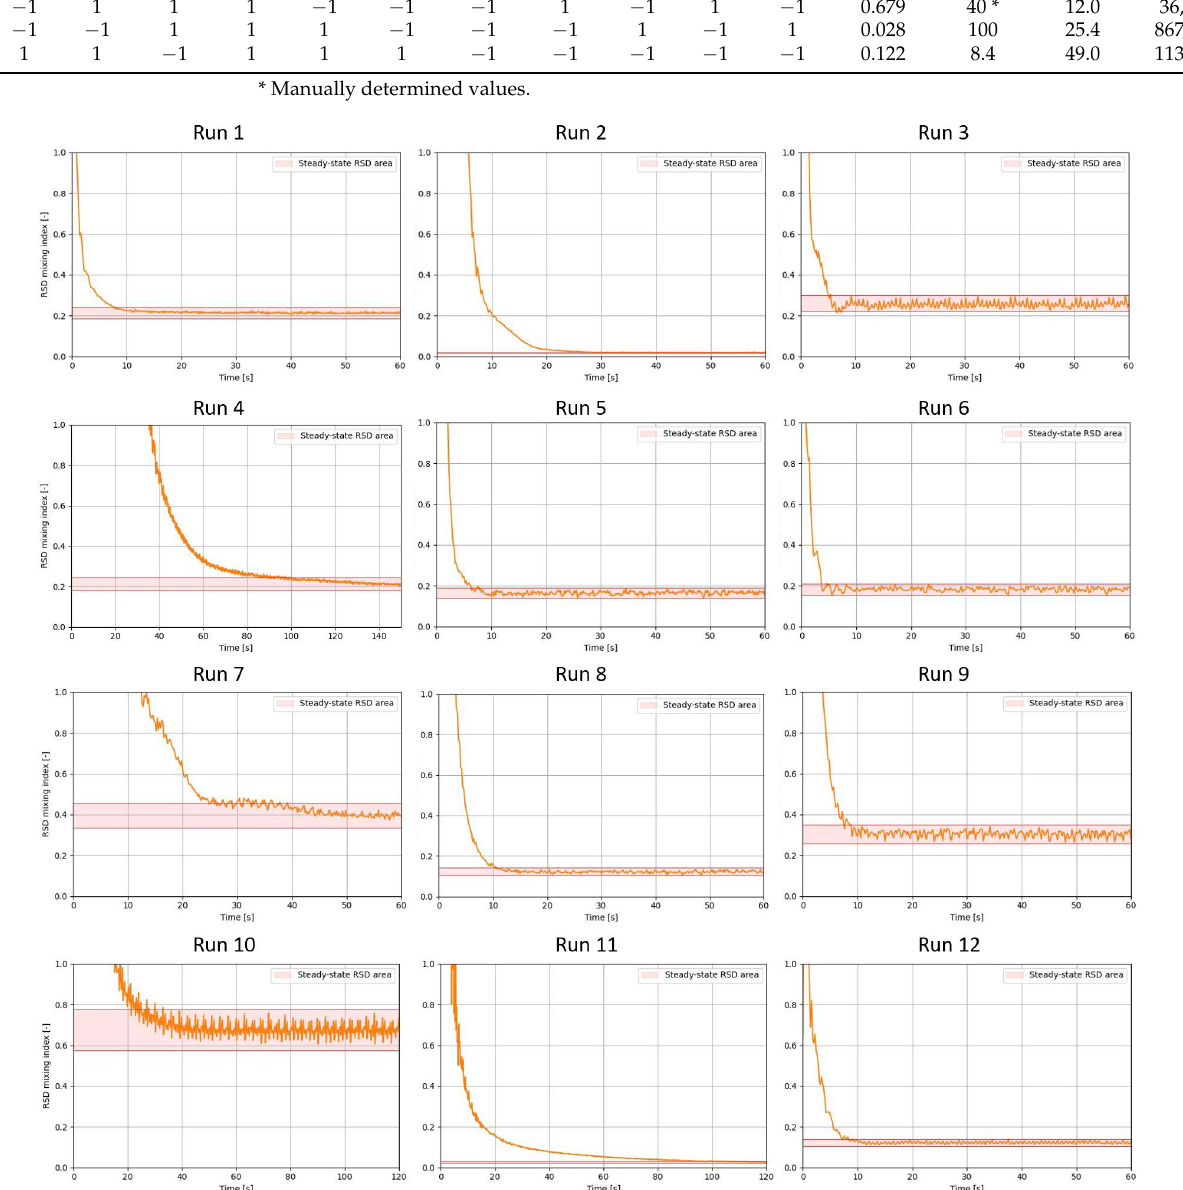
Figure 5. RSD – Time plots of all twelve runs as in Table